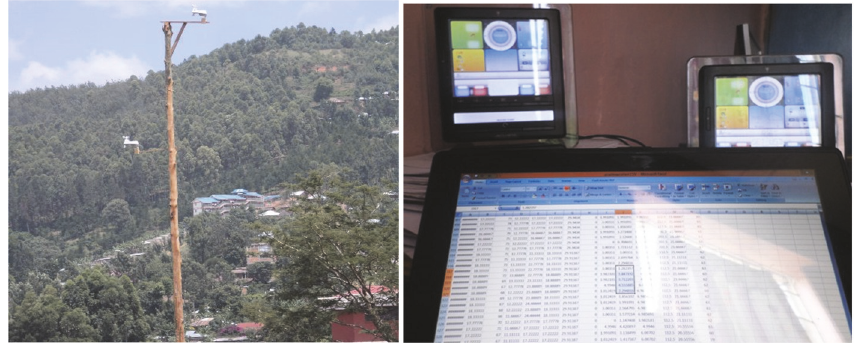
Figure 1: AcuRite wind sensors display boards and PC at Kisii